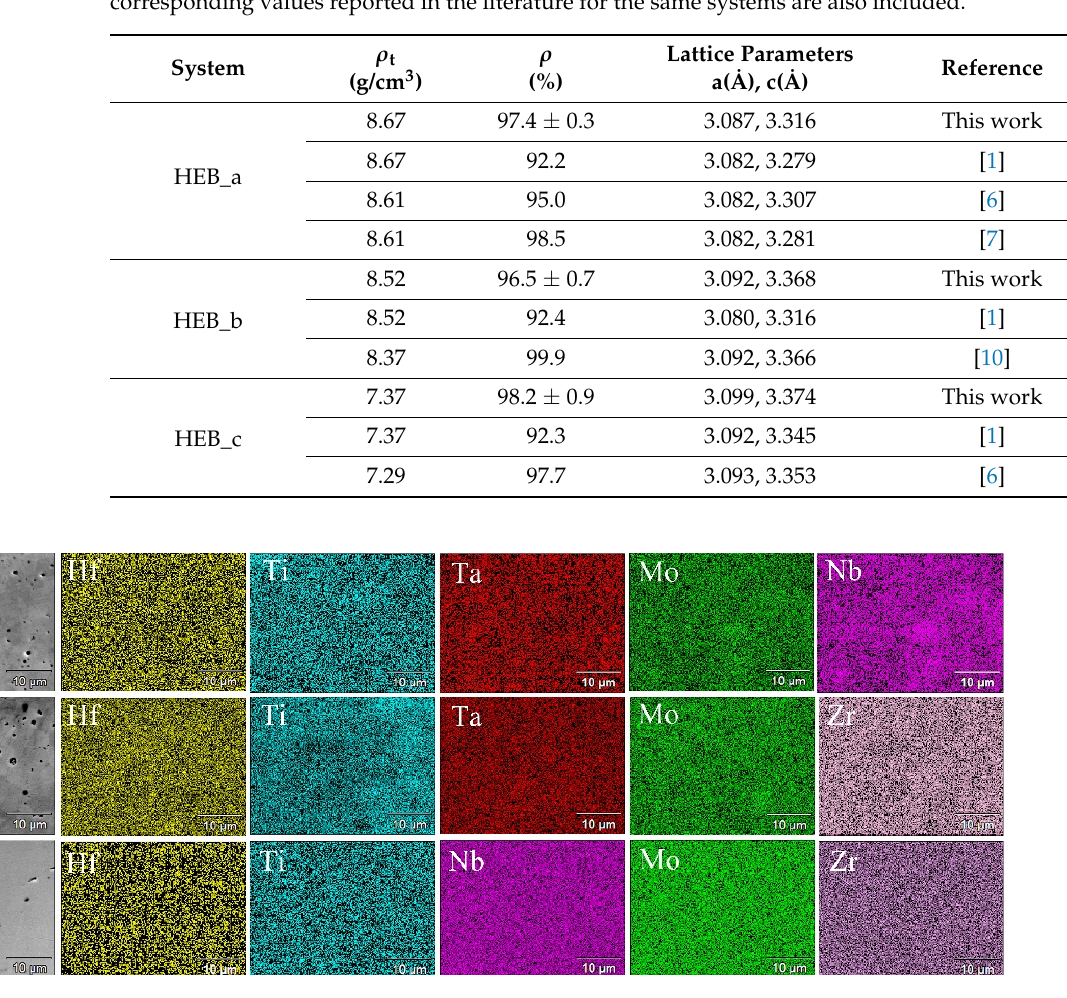
Figure 4. Cross sectional SEM micrographs and related EDS elemental maps of ( a ) HEB_a, ( b ) HEB_b, and ( c ) HEB_c products obtained by SPS from SHS powder.